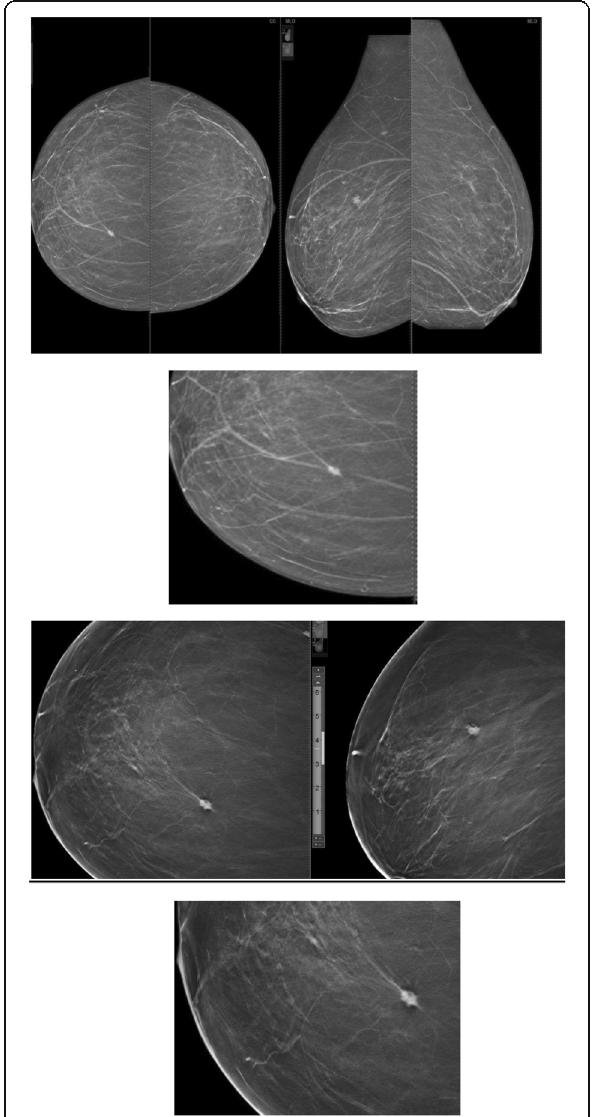
Fig. 7 Sixty-one-year-old female. Mammography CC and MLO views. Bilateral fatty breasts ACR A. Right UIQ small oval ill-defined mass lesion BIRADS 3. Tomosynthesis of the right breast CC and MLO views. The margin of the lesion appeared speculated on 3D digital tomosynthesis images (BIRADS 4). The tomosynthesis has better margin characterization, which easily detected the spiculated margin of this lesion and upgraded the BIRADS category from 3 to 4 ultrasound-confirmed speculated